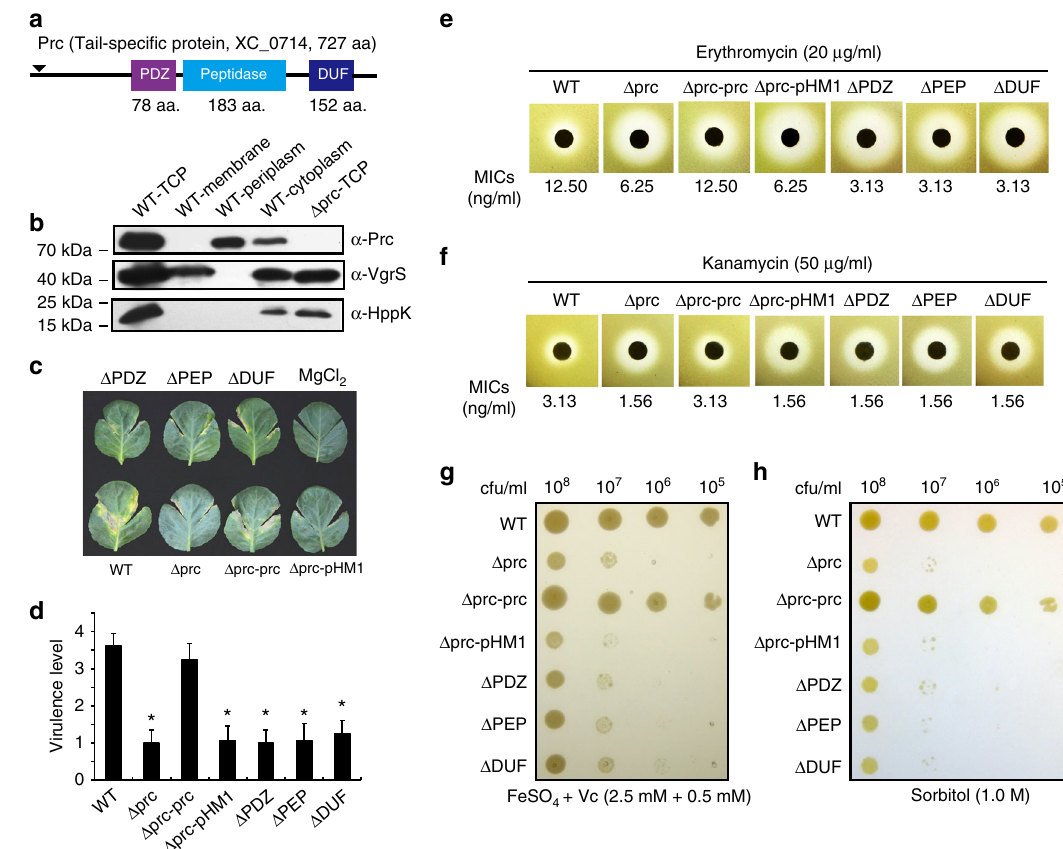
Fig. 1 prc of X. campestris pv. campestris controls virulence and stress resistance. a Schematic view of the secondary structure of the Prc protein. Domain names are according to the pfam database. b Prc is located in bacterial periplasm and cytosol. Western blotting was used to detect Prc proteins in different cellular fractions. TCP total cellular protein. Western blotting of the membrane-bound and cytosolic proteins VgrS and HPPK, respectively, were used as controls. The experiment was repeated three times. c The inactivation of prc caused a de fi ciency in virulence. Bacterial strains were inoculated into leaves of the host plant B. oleraceae cv. Jingfeng No. 1. Virulence scores were estimated 10 d after inoculation. Sterile 10 mM MgCl 2 was used as the negative control. d Virulence scores of bacterial strains as shown in c . The virulence levels of bacterial strains were estimated using a semi-quantitative standard. Asterisks indicate signi fi cant differences relative to the WT strain (Student's t -test, P < 0.05, n = 12). The result of the in planta growth assay is shown in Supplementary Fig. 2. e and f The prc mutant is sensitive to various antibiotics, including erythromycin e and kanamycin f . In both e and f , the inhibitory zones of antibiotics are shown. The minimal inhibition concentrations (MICs) of the antibiotics were measured and are listed below. Each experiment was repeated three times. g The inactivation of prc resulted in hypersensitivity to iron stress. Bacterial strains were grown on NYG agar containing 2.5 mM FeSO 4 plus 0.5 mM vitamin C for 72 h at 28 °C. The experiment was repeated three times. h The inactivation of prc resulted in hypersensitivity to osmostress. Bacterial strains were grown on NYG agar containing 1.0 M sorbitol for 72 h at 28 °C. The experiment was